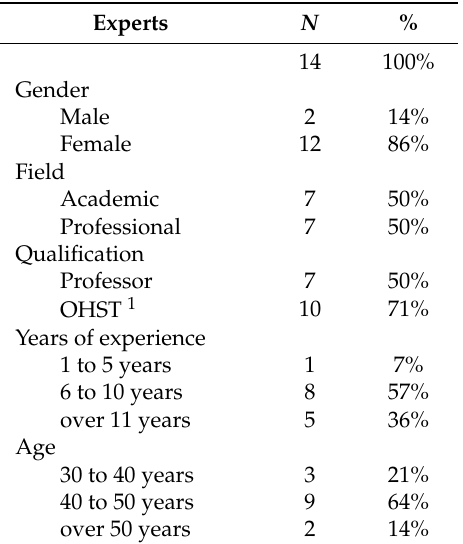
Table 1. Sociodemographic characteristics of the